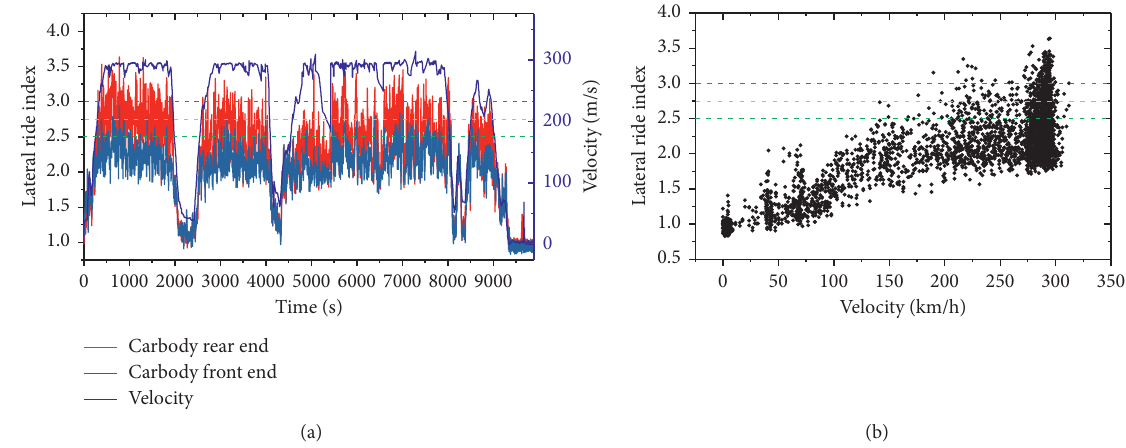
Figure 4: Lateral ride index in the field test based on the (a) time and (b) velocity domain.